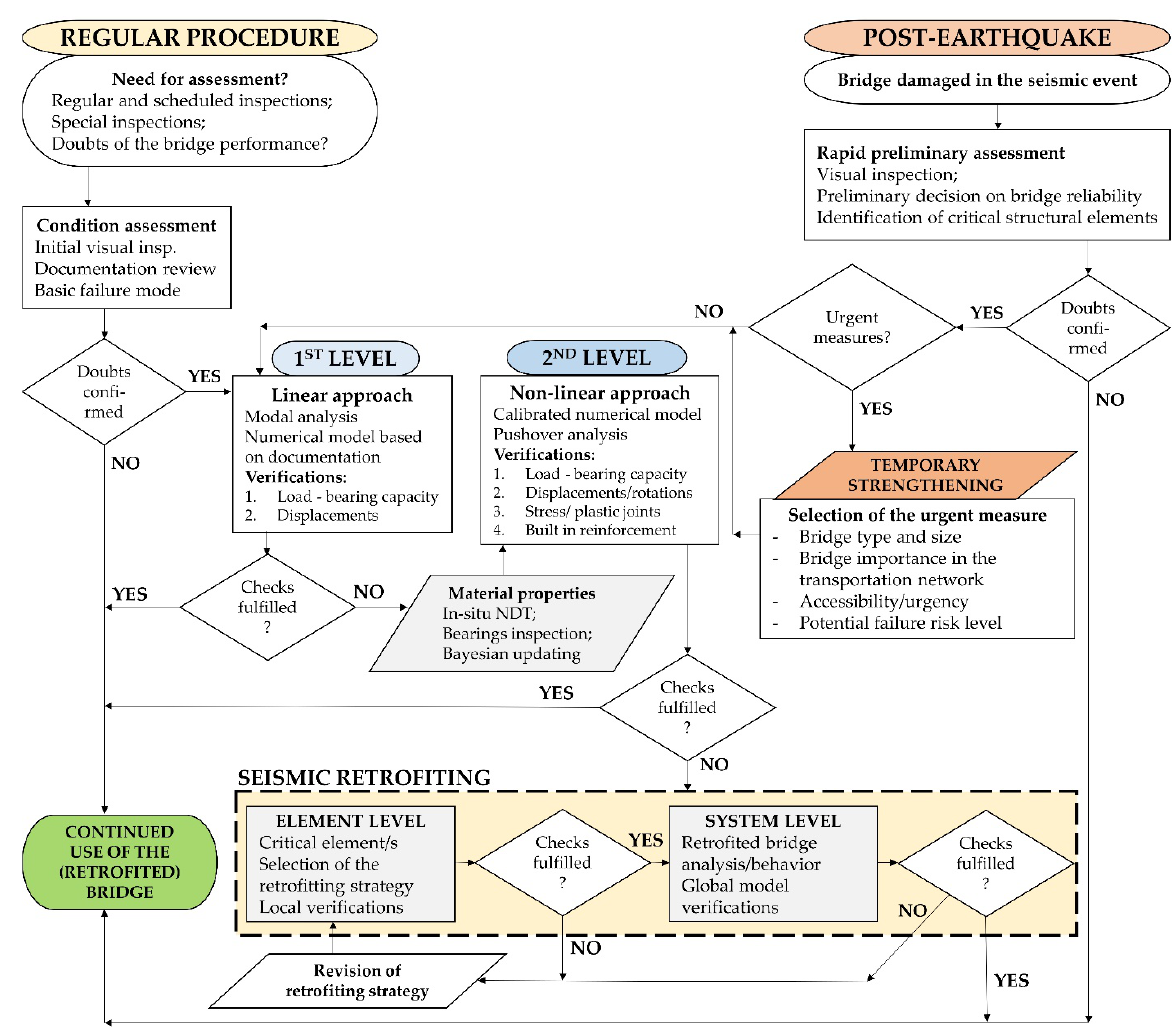
Figure 16. Proposed multi-level assessment method for typical existing road bridges.